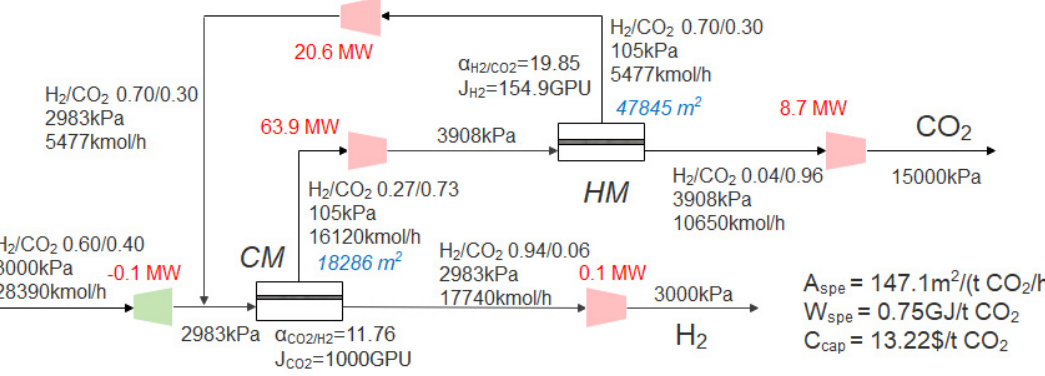
Figure 10. The optimal process when the performance of the H 2 -selective membrane changes based on the Robeson upper bound.